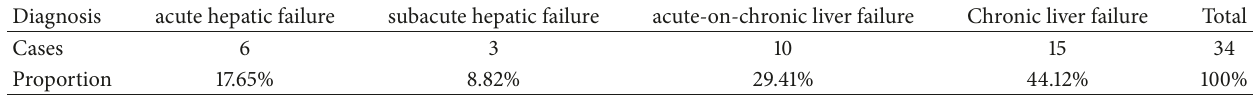
Table 2: Diagnosis and classification of plasma exchange for liver